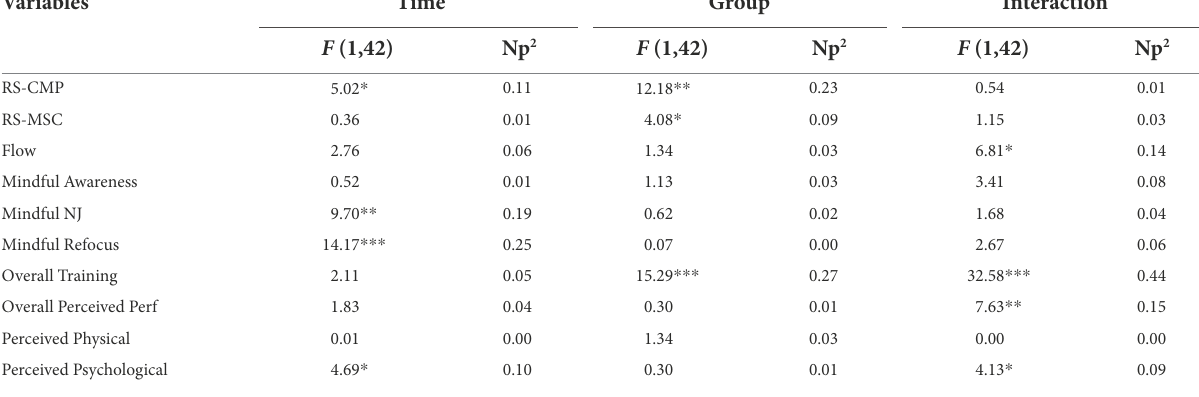
TABLE 3 Two-way ANOVA effects for dependent